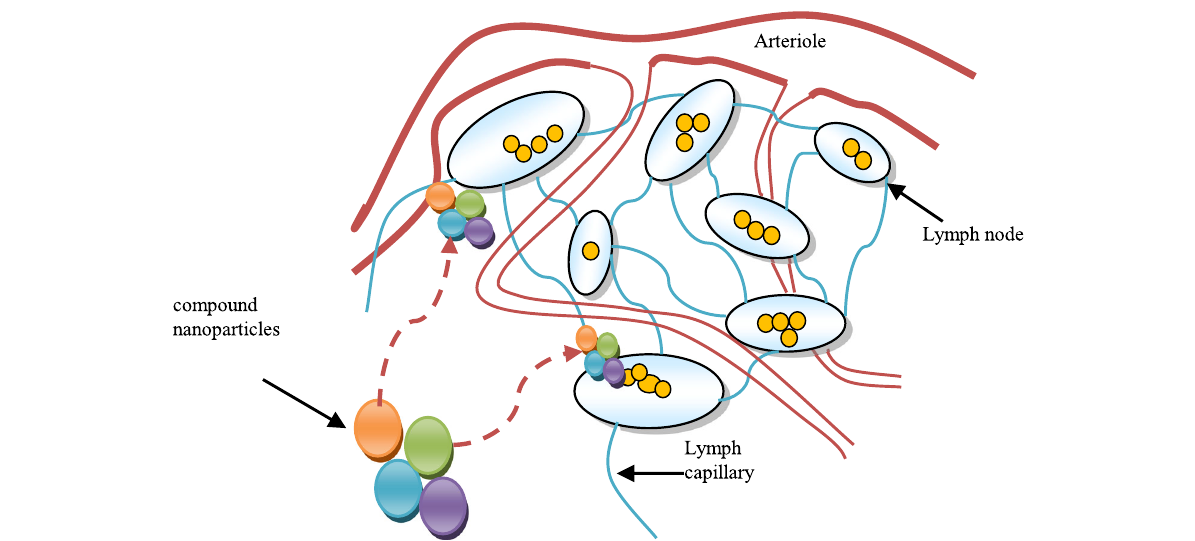
Fig. 1 Compound nanoparticle drug delivery system and its interaction with lymph